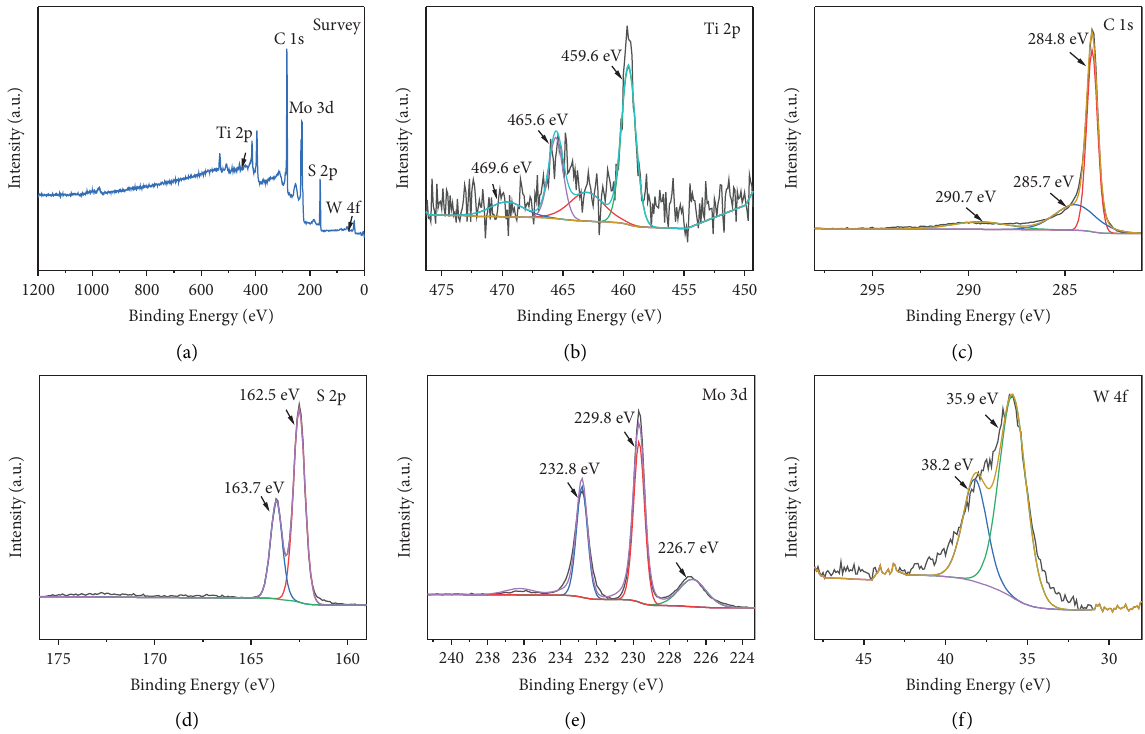
Figure 6: XPS spectra for the MoWS 2 @MXene@CNT: (a) survey, (b) Ti 2 p , (c) C 1 s , (d) S 2 p , (e) Mo 3 d , and (f) W 4 f